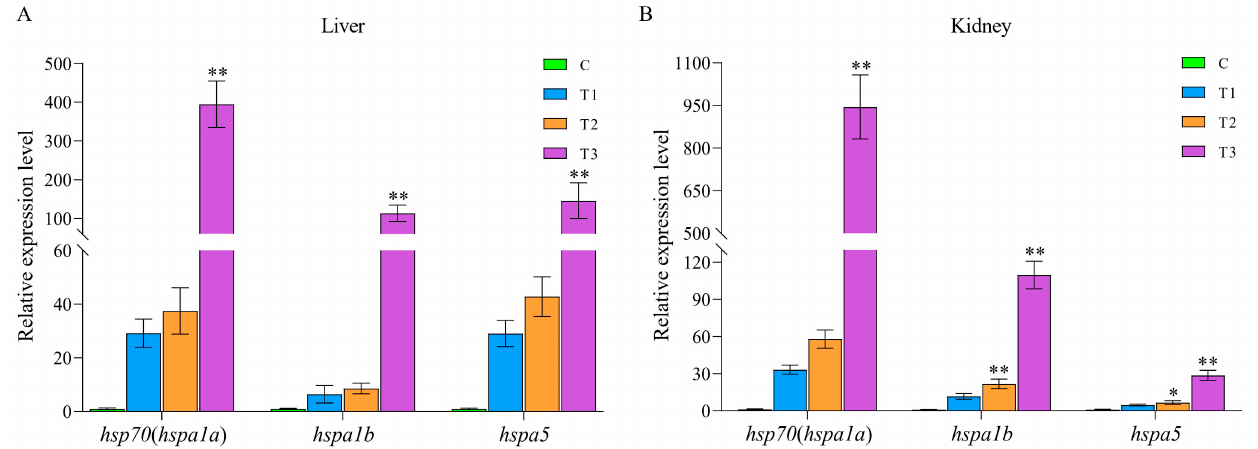
Figure 8. The validation of expression patterns of hsp70 ( hspa1a ), hspa1b , and hspa5 in liver ( A ) and kidney ( B ) tissues at 24 h after heat stress. The mRNA expression levels were determined by qPCR analysis using the 2 −ΔΔ Ct method. C, T1, T2, and T3 represent 18 °C, 22 °C, 26 °C, and 30 °C heat treatment groups, respectively. * and ** indicate the significant differences at p < 0.05 and p < 0.01 between the control (C) and heat treatment groups (T1, T2, and T3), respectively.